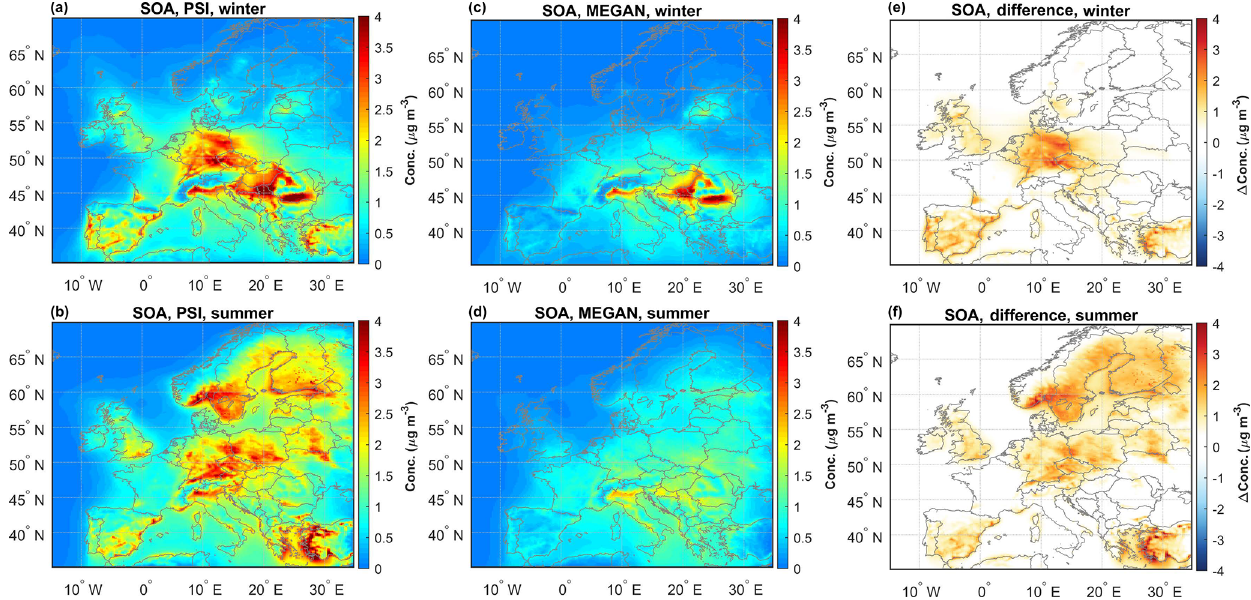
Figure 9. Modelled SOA concentrations using PSI emissions (PSI SOA) (a, b) , MEGAN emissions (MEGAN SOA) (c, d) , and the difference between PSI SOA and MEGAN SOA (e, f)